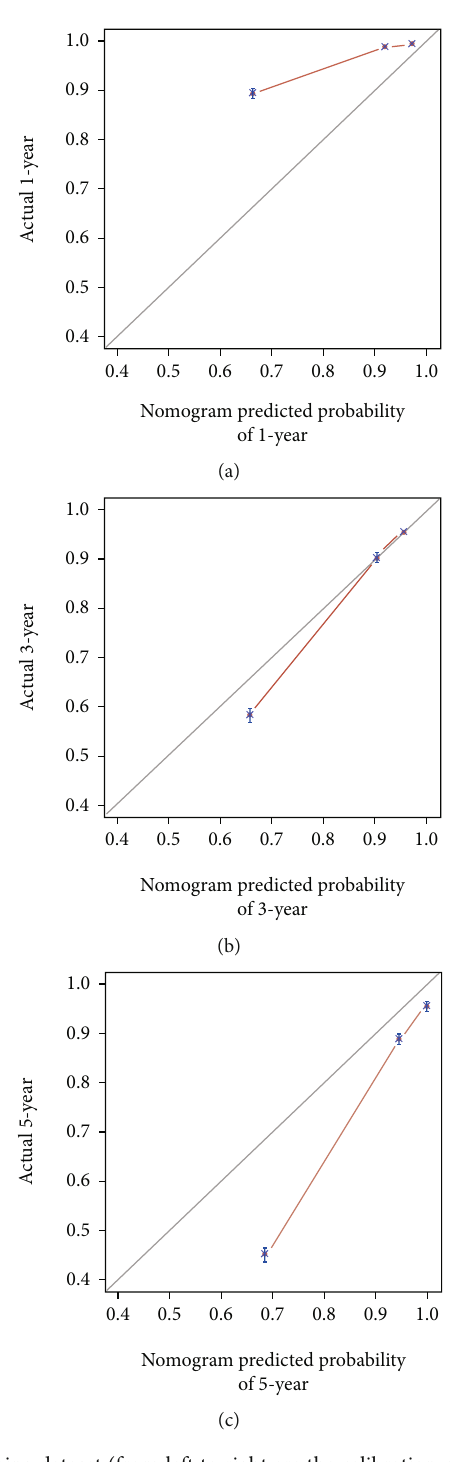
Figure 3: The calibration curves in the training dataset (from left to right are the calibration curves for the prediction of survival in year 1, year 3, and year 5,